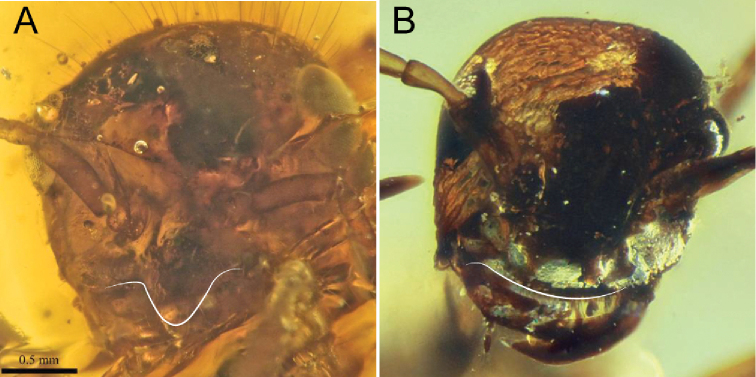
Facial views of †Sphecomyrminae which have short mandibles A †Sphecomyrma
mesaki Engel & Grimaldi, 2005, holotype worker, anterodorsal oblique (AMNH-NJ1023, AntWeb: Dave Grimaldi and Vincent Perrichot) B †Gerontoformica species, worker, full-face (ANTWEB1032418).